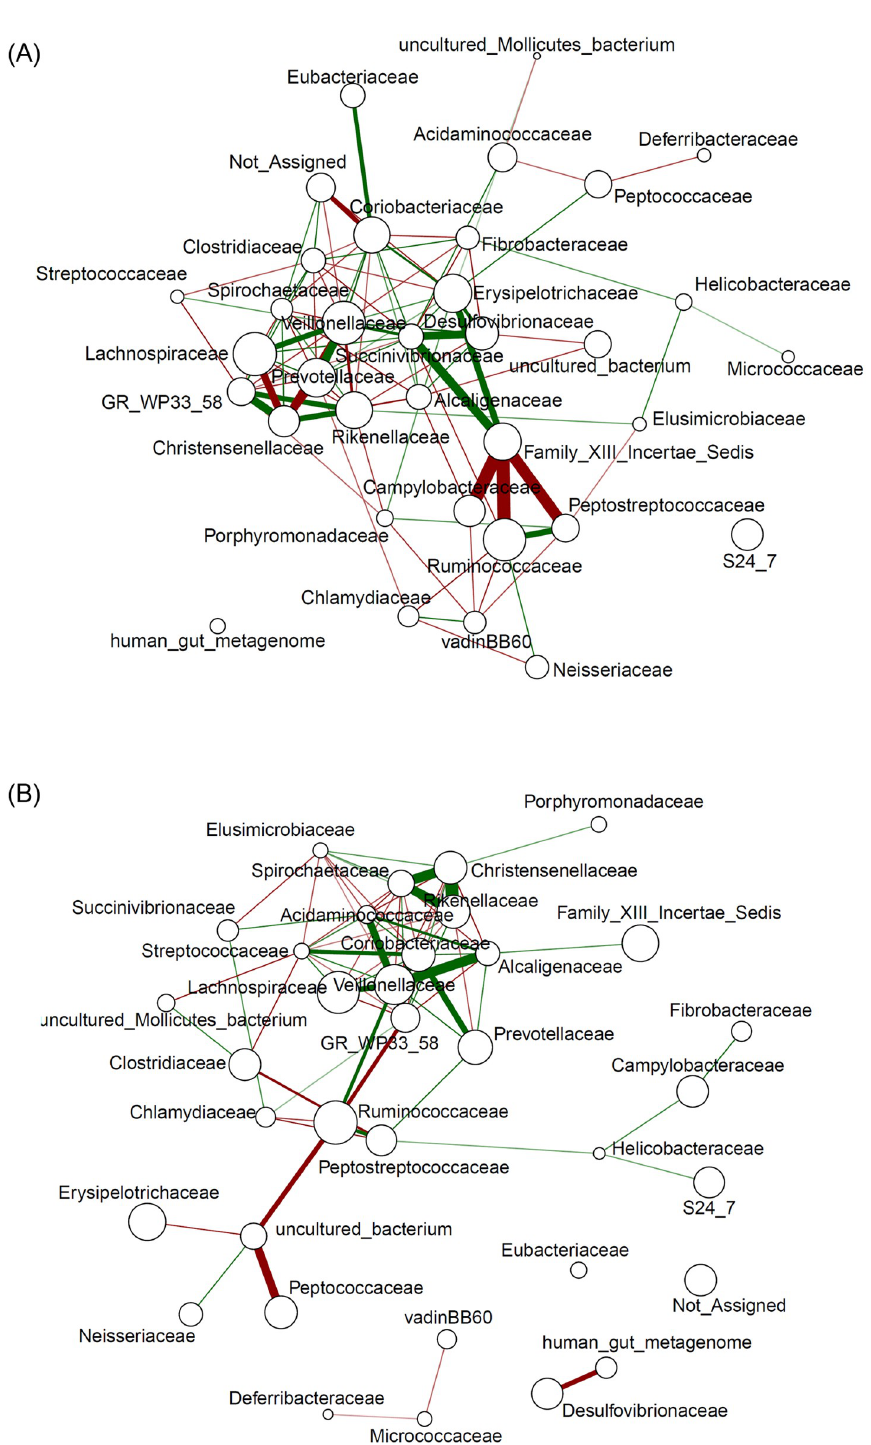
Fig 6. SparCC co-occurrence network analysis at the family level of the control (A) and the tannin (B) group microbiota. The node size represents the relative abundance of families. Lines represent correlations between the nodes they connect. The green colour of an edge indicates positive correlations, whereas the red colour denotes negative correlations. The colour intensity and line thickness indicate the correlation magnitude. Only significant correlations (p < 0.05) are